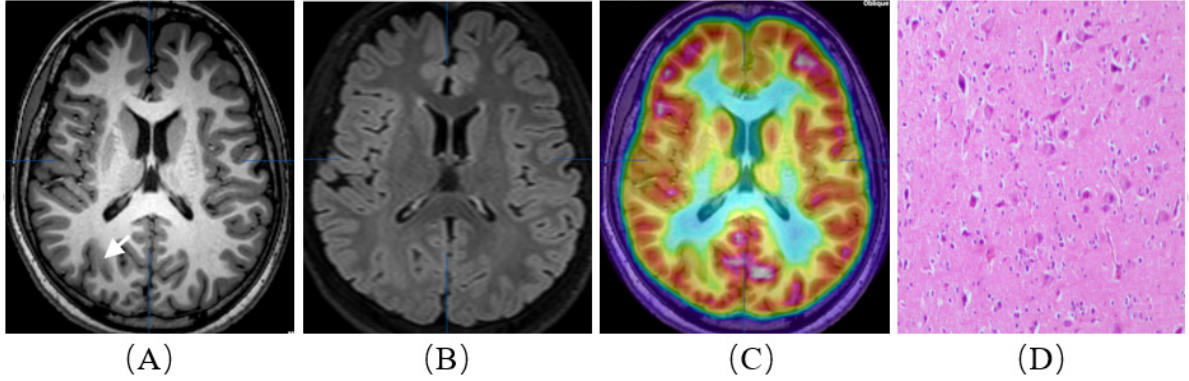
Figure 2. A patient with refractory epilepsy to drug therapy. He was born in 2003 and was admitted when he was 14 years old. His first seizure occurred at two years old. Interictal and ictal EEG recordings indicated the right parietal occipital lobe region. MRI showed cortical and subcortical signal abnormalities on axial TIWI ( A ) and FLAIR T2WI ( B ) in the right parietal occipital lobe. (18F)- FDG PET/MRI images ( C ) demonstrated hypometabolism in the parietal occipital lobe extending also to the parietal occipital area on the right. Resective surgery was planned for the patient, and an intracranial electrode was not used. Postoperative histopathological examination ( D ) confirmed ‘type II a, focal cortical dysplasia’. The patient is currently seizure ‐ free (Engel I).